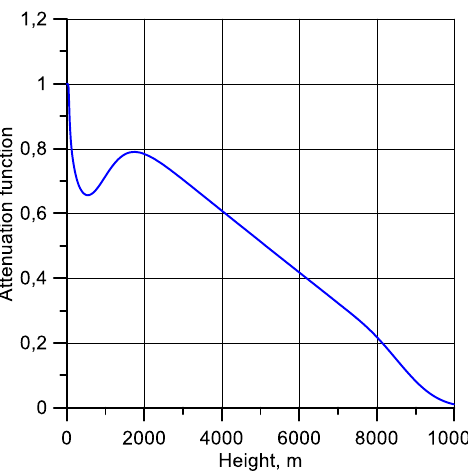
Figure 10. Attenuation function derived from the radiation field depicted by curve 1 in Figure 7 using Equation (12), assuming that the channel base current propagates upwards without dispersion.